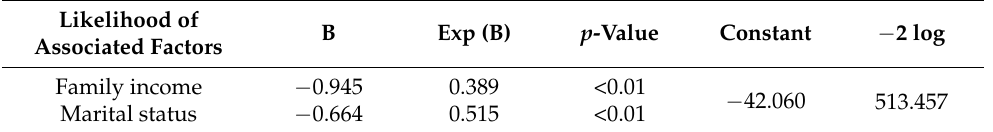
Table 3. Final model of binary logistic regression of sociodemographic factors associated with the lifestyle of workers participating in the